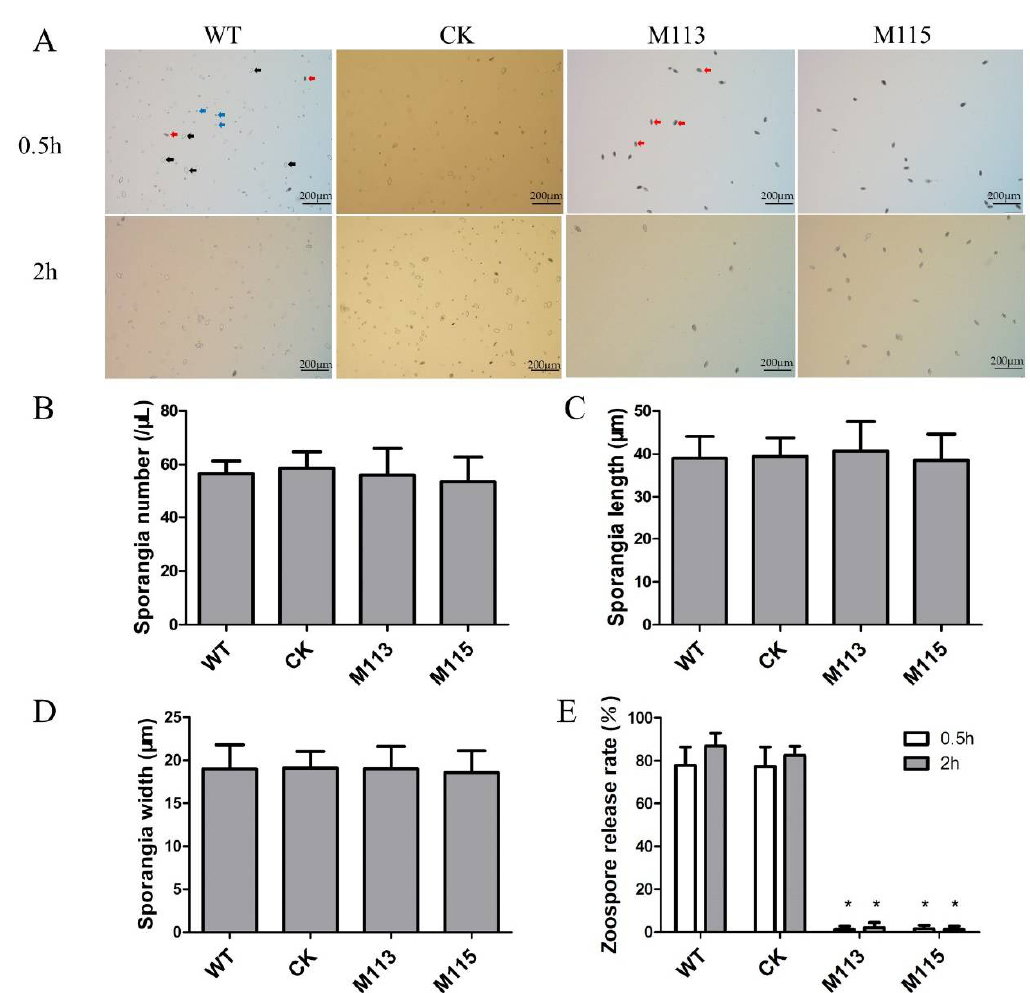
Figure 3. Knockout of PlMAPK2 decreased the zoospores release rate. PlMAPK2 mutants, CK (the transformant failed to acquire PIMAPK2 mutation) and WT (wild type) were cultured on CJA medium for 7 days and sporangia were collected and used for releasing zoospores. ( A ) Photographs were taken 0.5 and 2 h after releasing zoospores. Scale bar = 200 μm. Black arrows indicate the representative released sporangia; red arrows indicate representative unreleased sporangia; blue arrows indicate representative zoospores. ( B ) The sporangia numbers were calculated. ( C , D ) The sporangia lengths and widths were measured. ( E ) The zoospore release rates of PlMAPK2 mutants, CK and WT were calculated after 0.5 and 2 h. Asterisks indicate significant difference between WT and PlMAPK2 mutants ( t -test, p < 0.01). These experiments were replicated three times.